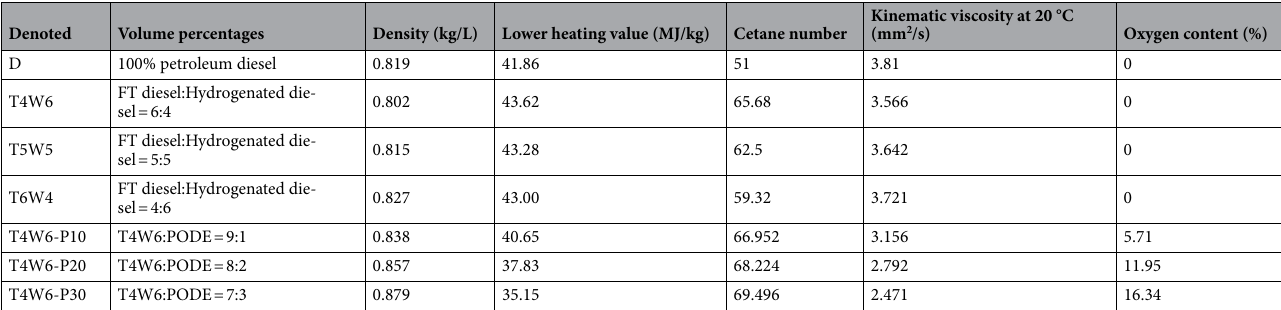
Table 4. Physical and chemical properties of the test